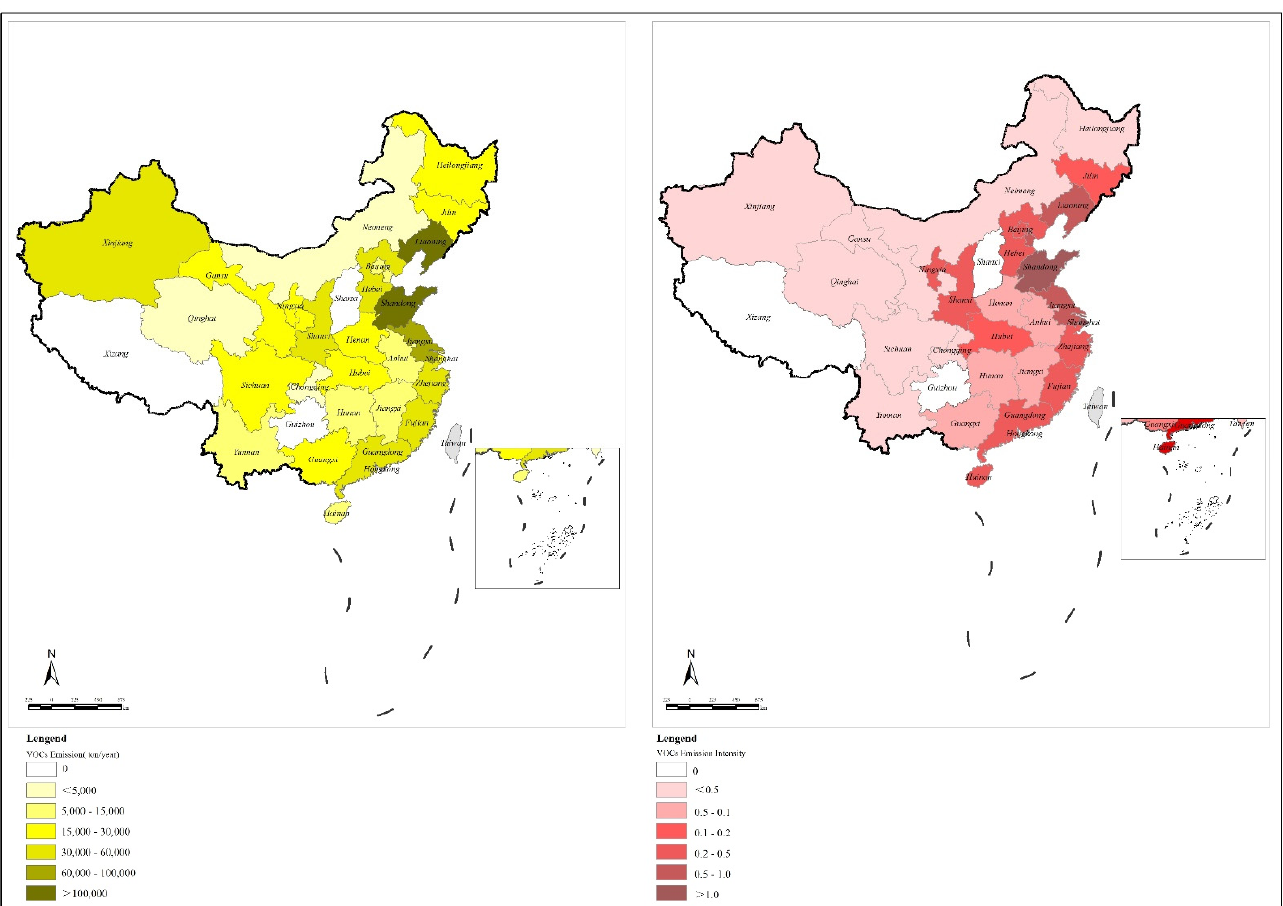
Figure 3. Distribution of VOC emissions and emission intensity per unit land area in the PR industry in China. in